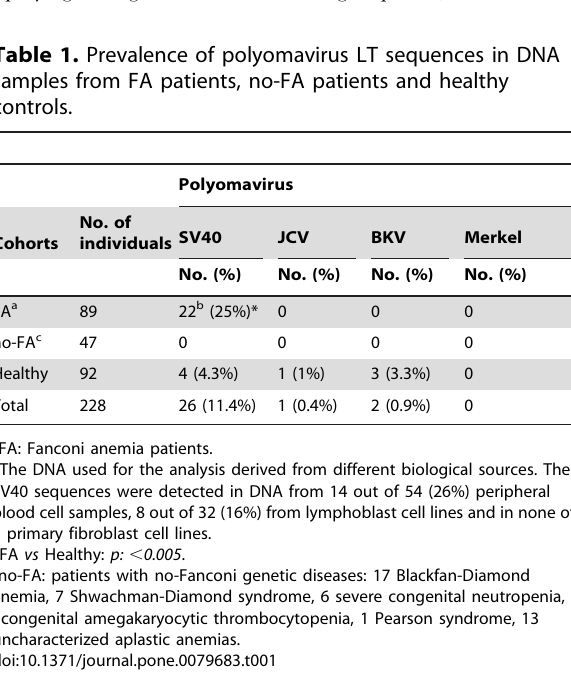
Table 1. Prevalence of polyomavirus LT sequences in DNA samples from FA patients, no-FA patients and healthy controls.